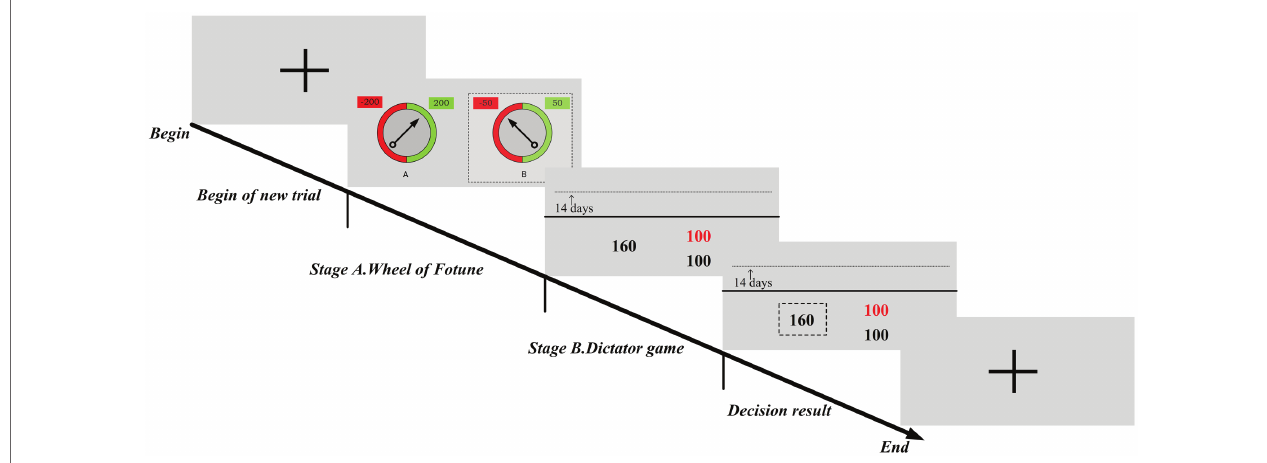
FIGURE 2 | In each trial, there are three screens. The first screen informs about the outcome of the risky gambling task shown in Figure 1 . The second screen displays two options, where the option on the left implies a selfish choice and the option on the right implies a generous choice. The black-coded numbers under the scale indicate the participant himself, and the red-coded numbers represent the amount of the recipient’s reward. The third screen presents the decision